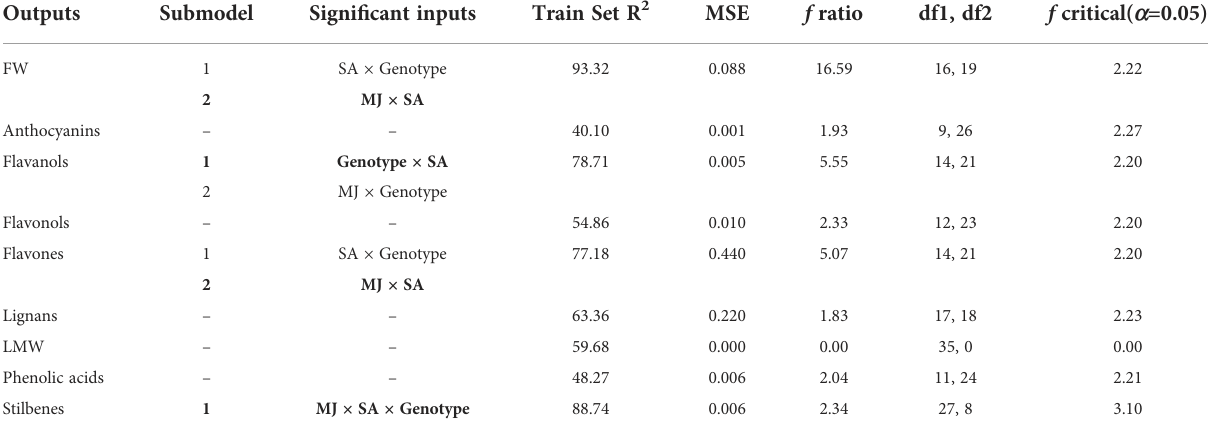
TABLE 3 Critical factors and quality parameters detected by the NFL model for all the outputs evaluated.